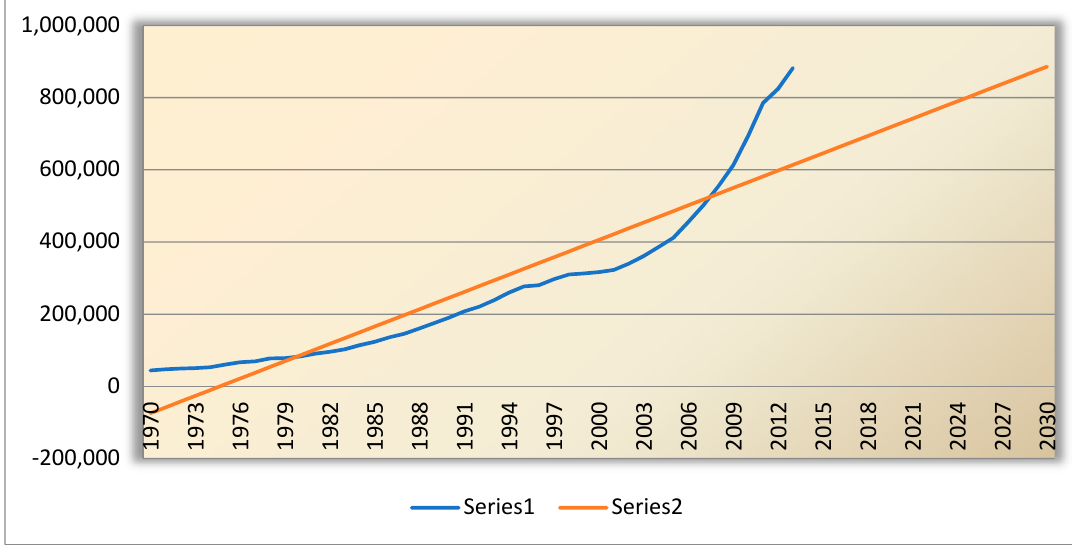
Figure 11. Chart for Linear method (1971–2030).